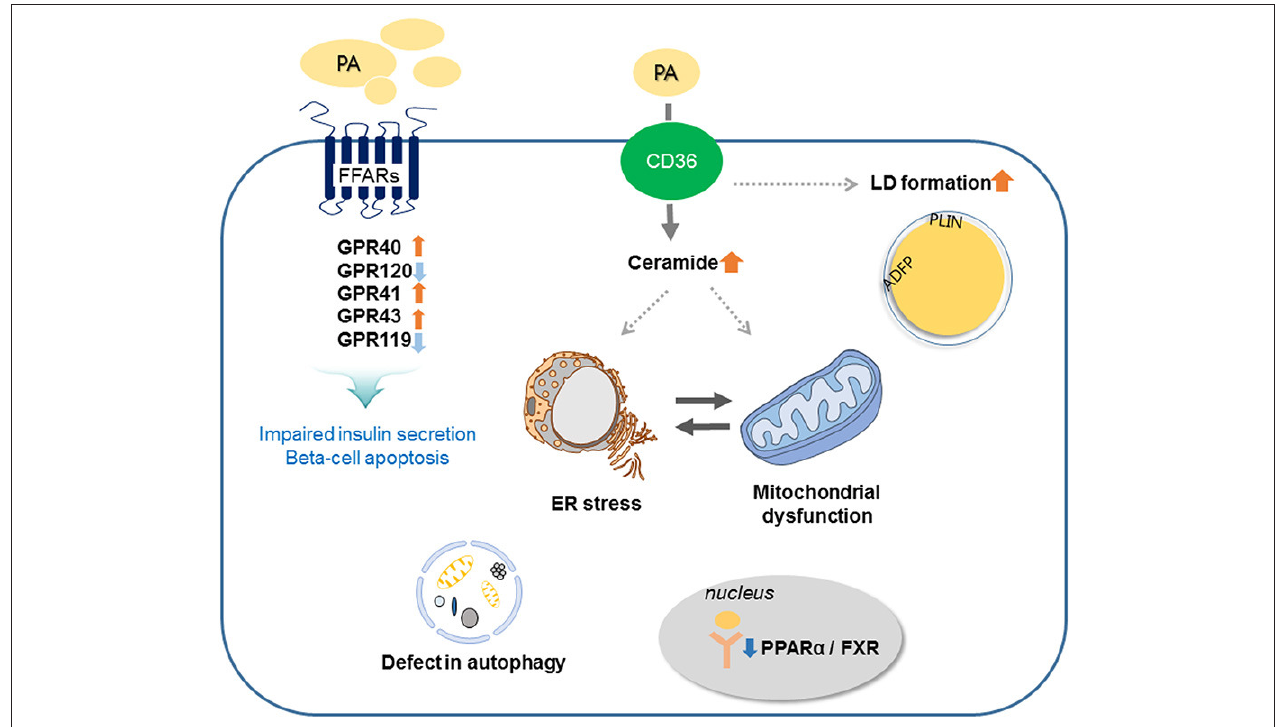
FIGURE 2 | Involved mechanisms regarding impaired insulin secretion and beta-cell apoptosis under lipotoxic condition in pancreatic beta-cells. Palmitate (PA) activates CD36 or FFA receptors (FFARs) and cell stress responses including ceramide formation, lipid droplet (LD) formation, endoplasmic reticulum (ER) stress, mitochondrial dysfunction, and autophagy. These responses result in beta-cell damage and impaired insulin